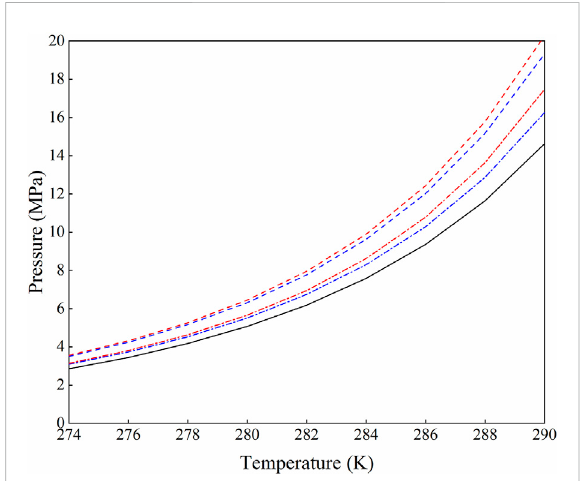
FIGURE 1 The solid curve is hydrate stability limit for hydrate formed from purewater and CH 4 ,red dash-dot isfor hydrateformedfrom a 2 wt% methanol in water solution and CH 4 , blue dash-dot is for hydrateformedfroma2 wt%NaClinwatersolutionandCH 4 , red dashed is for hydrate formed from water in a 5 wt% methanol in water solution and CH 4 , and blue dashed is for hydrate formed from water in a 5 wt% NaCl in water solution and CH 4